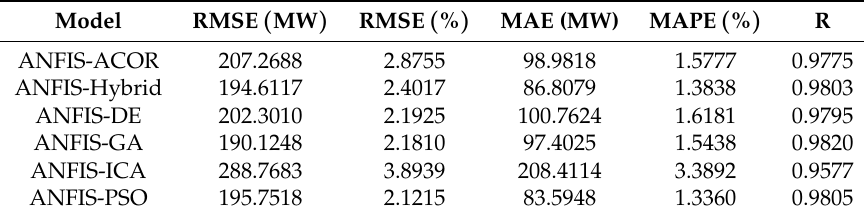
Table 2. Forecasting results for each model.